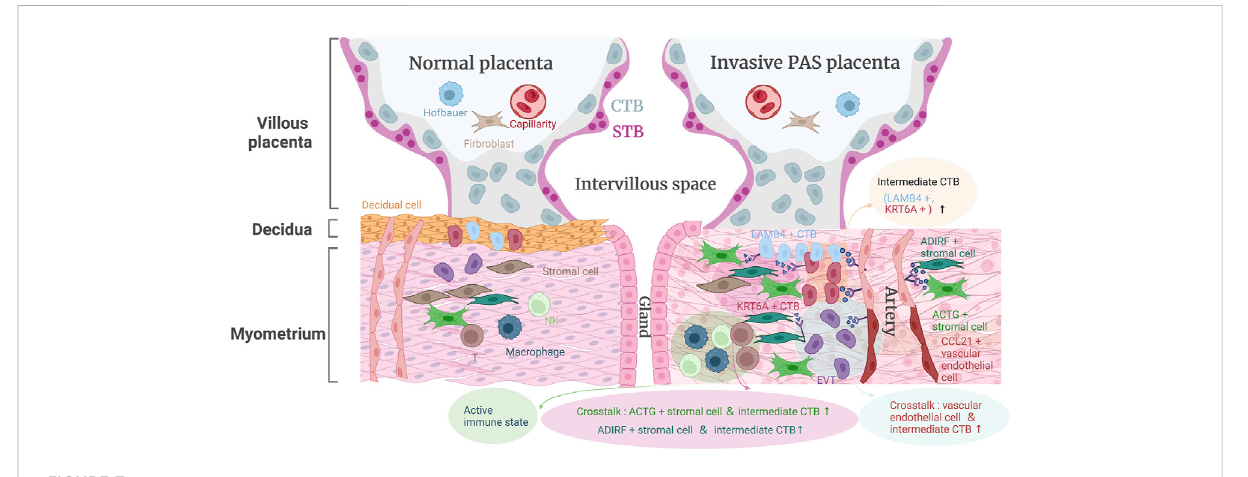
FIGURE 7 The landscape model of placenta accreta spectrum disorders